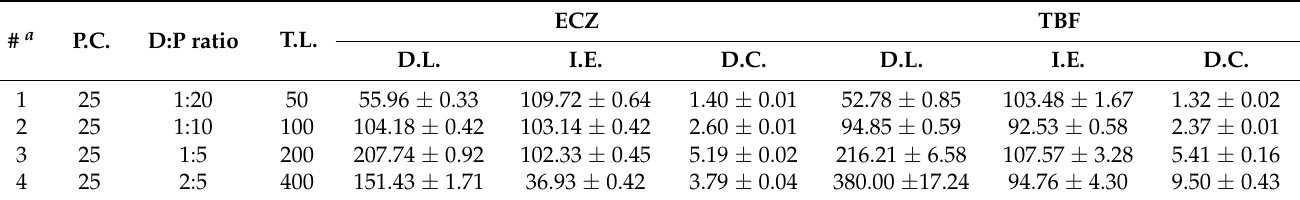
Table 1. Drug content of ECZ- and TBF-loaded micelles.